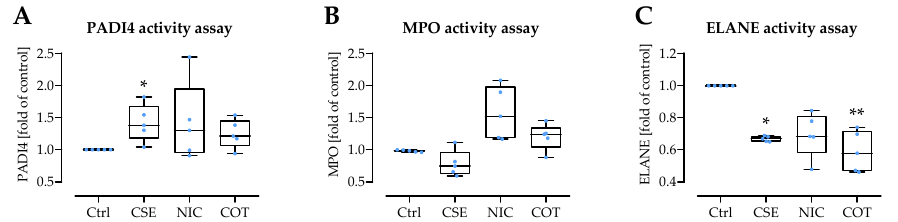
Figure 7. Influence of CSE, nicotine, and cotinine on activity of enzymes involved in NET formation. The effects of 20% CSE, 200 ng/mL nicotine (NIC), or 200 ng/mL cotinine (COT) on the activity of isolated enzymes involved in NET formation were determined. Enzyme activities analyzed were ( A ) peptidyl-arginine-deiminase 4 (PADI4), ( B ) myeloperoxidase (MPO), ( C ) neutrophilic elastase (ELANE). ( N = 4, n = 2). Data are presented as box blots with individual measurement points, median, and interquartile range. Groups were compared by non-parametric Kruskal–Wallis test followed by Bonferroni multiple comparison test. * p < 0.05 and ** p < 0.01 as compared to the respective control group (Ctrl).